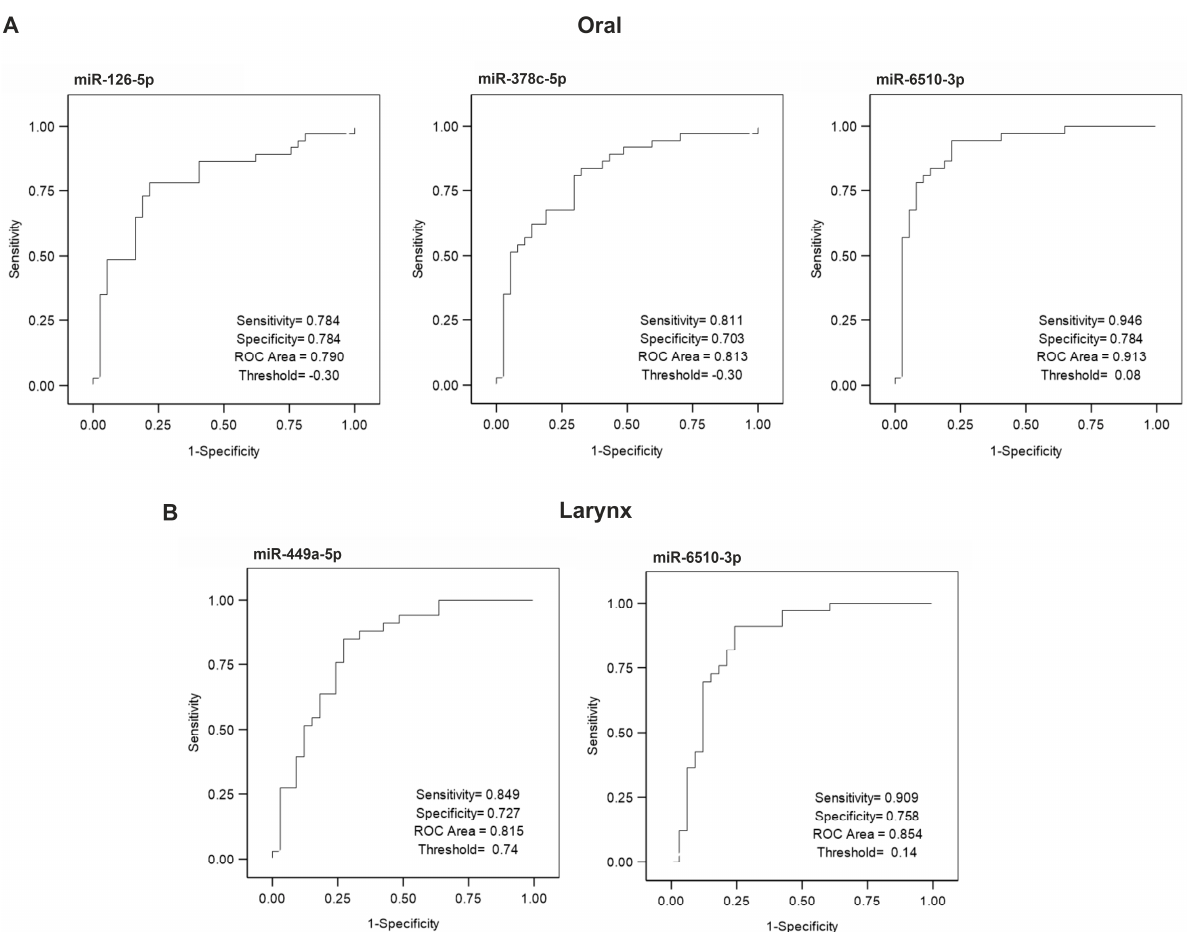
Figure 3. ROC curves showing miRNA biomarkers with potential in distinguishing tumor tissue from nearby healthy tissue in oral ( A ) and laryngeal ( B ) cancer.